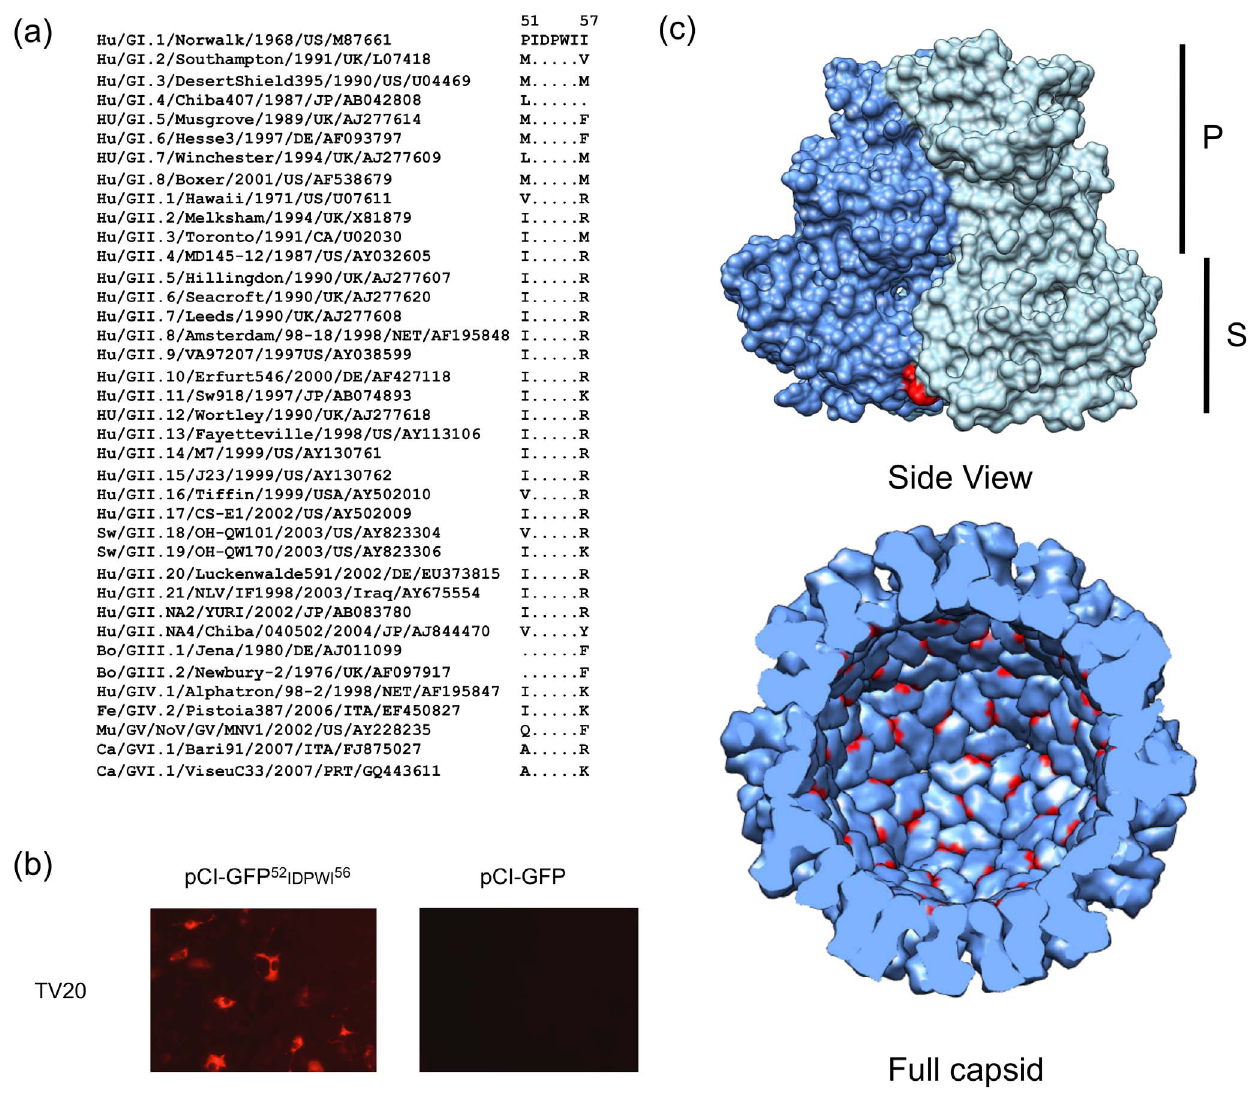
Figure 3. Putative epitope from MAb TV20 is highly conserved among noroviruses. (A) Amino acid alignment (residues 51–57) from representative noroviruses from the six genogroups described. Same residue is represented by a dot. MAb TV20 reactivity is indicated on the right- hand side: ‘‘ + ’’ positive, ‘‘NT’’ not tested. (B) Reactivity of MAb TV20 with cells expressing the putative epitope (residues 52–56) fused at the C- terminus of the green fluorescent protein. Experiments were performed as described in Materials and Methods . (C) Structure of NV VP1 (PDB: 1IHM) showing the location of the putative epitope from MAb TV20 (highlighted in red) in the context of the VP1 dimer and the whole capsid. The domains of the VP1 are shown on the right-hand side.